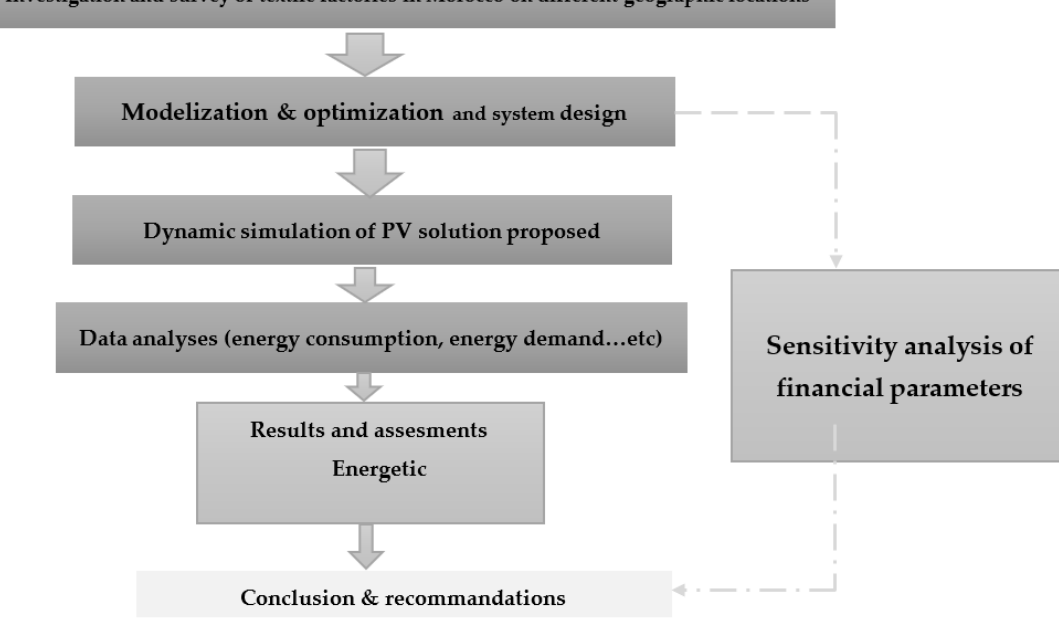
Figure 7. Analytical framework methodology.